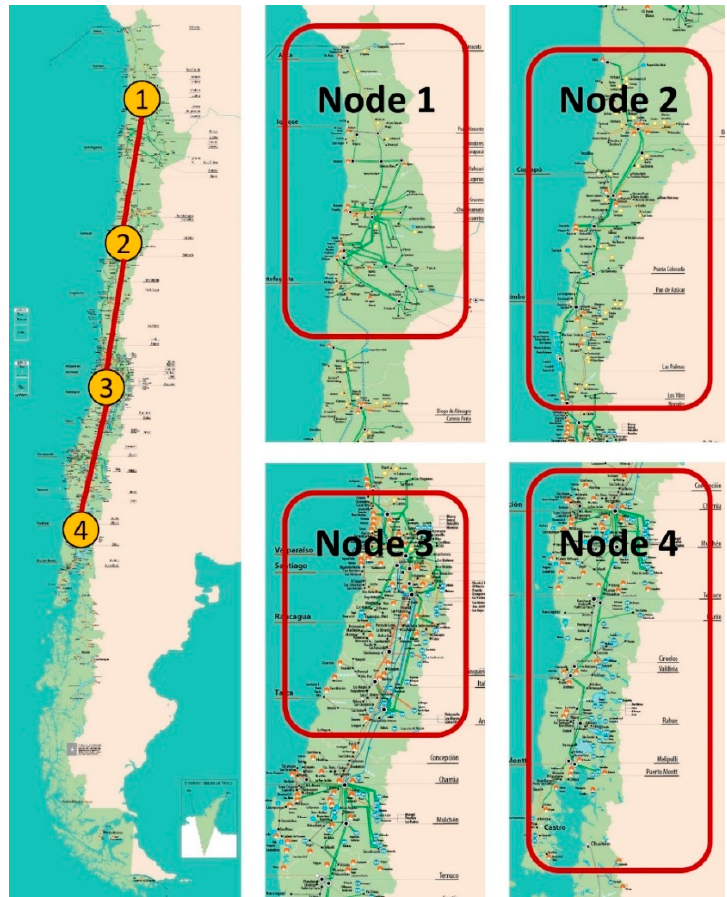
Figure 1. Nodes considered in the model [22].